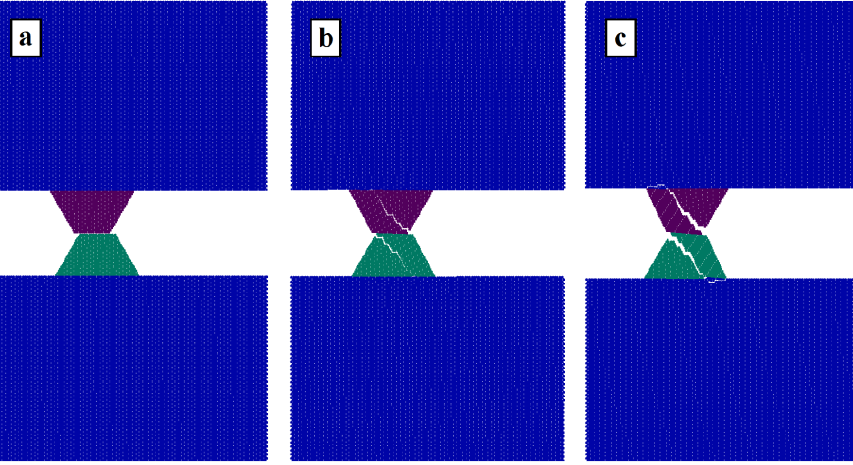
Fig. 4. “Cleavage” regime of asperities